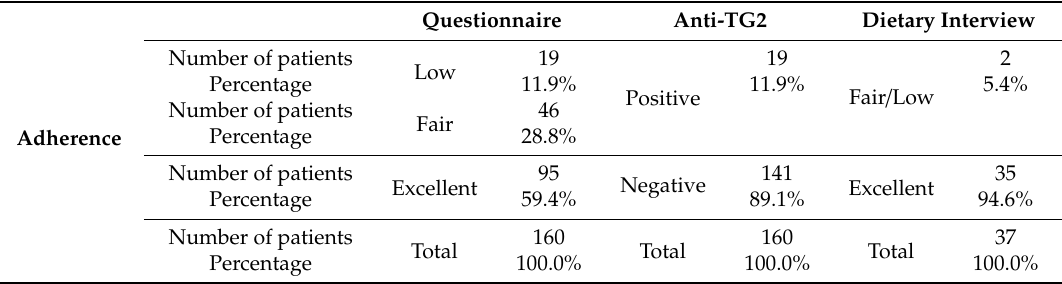
Table 3. Adherence to GFD assessed through the questionnaire compared with serology (Anti-TG2) and dietary interview. Questionnaire